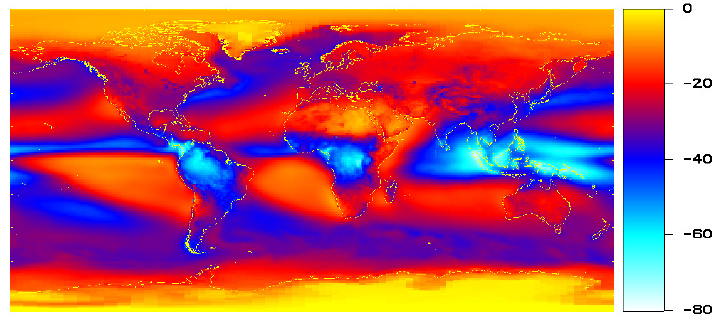
Figure 3. 2001–2017 mean cloud effect CERES OLR. The scale is in W/m 2